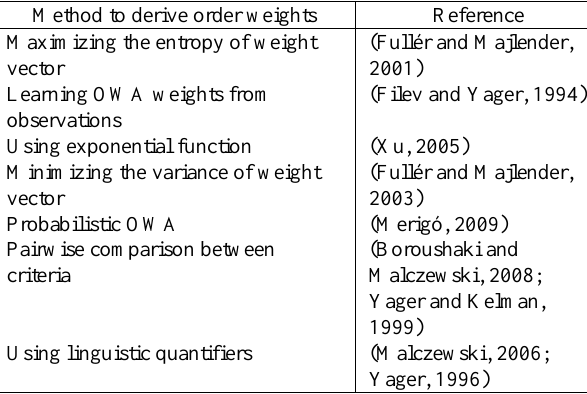
Table 1. Fundamental methods of deriving OWA